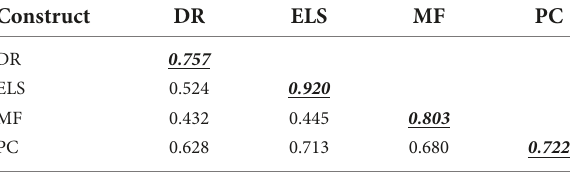
TABLE 2 Discriminant validity (Fornell-Larker-1981 Criteria).